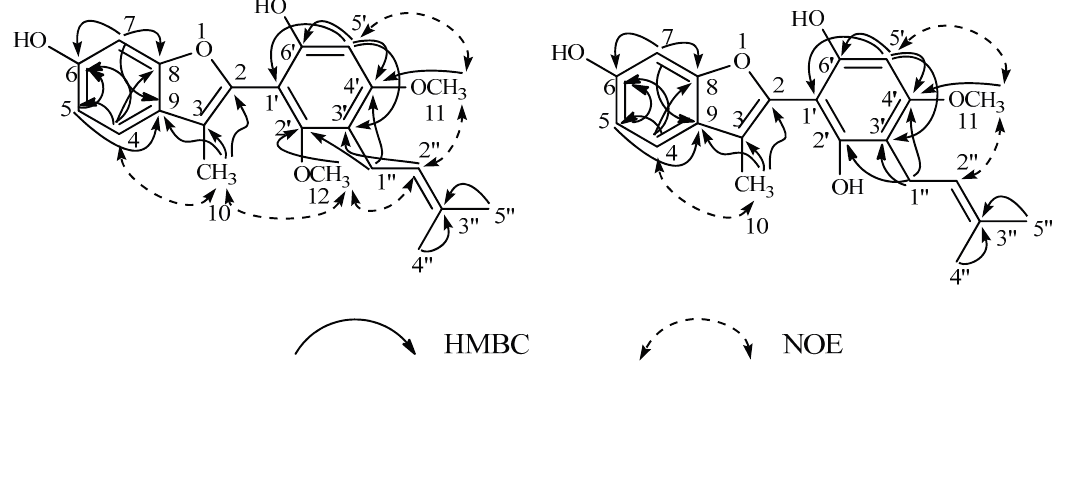
Figure 2. HMBC and NOESY correlations observed for compounds 8 and 14